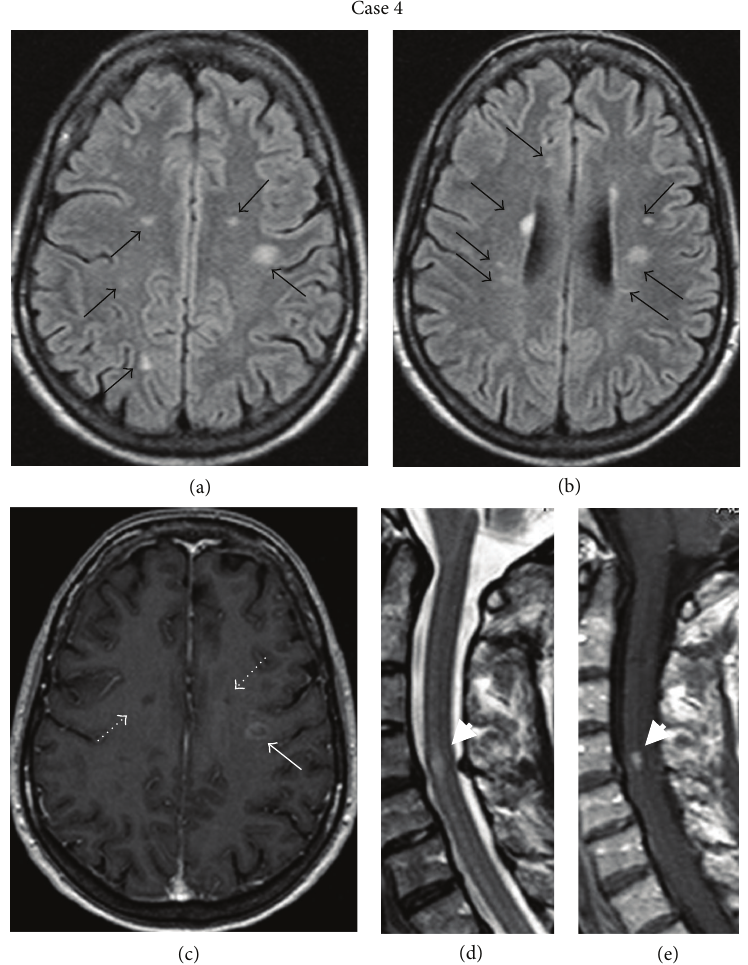
Figure 4: (a) and (b) Axial FLAIR brain MRI images of the fourth patient demonstrating multiple periventricular and subcortical lesions at the frontal, parietal, and temporal lobes (black arrows). (c) Axial T1-weighted brain MRI image showing gadolinium ring enhancement in one of the subcortical lesions (white arrow) and two subcortical black holes (white dotted arrows) (e) Sagittal T2- and (f) T1-weighted MRI of the cervical spine showing one hyperintense lesion at the C4-C5 level with gadolinium enhancement (white